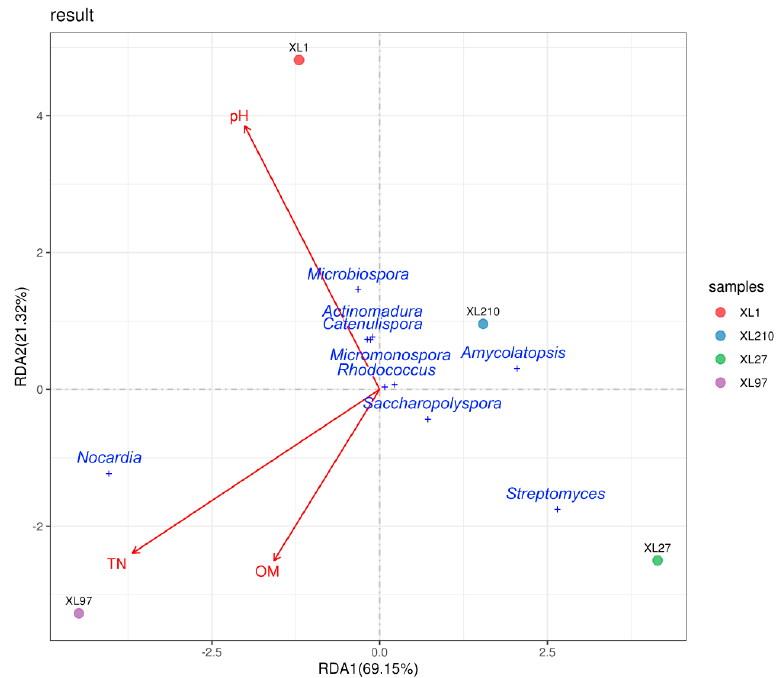
Figure 3. Redundancy analysis (RDA) for endophytic actinobacterial community and physiochemical properties of rhizosphere soil samples across different C. oleifera samples.